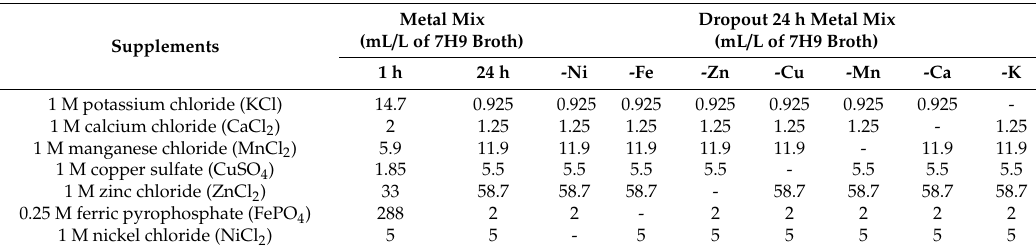
Table 1. Concentrations of single elements present in the metal mix and dropout